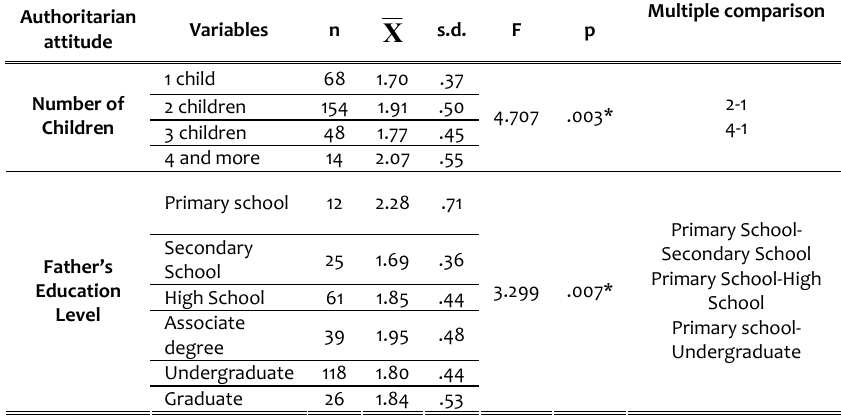
Table 6. Results of ANOVA test related to PAS authoritarian attitude subscale scores and